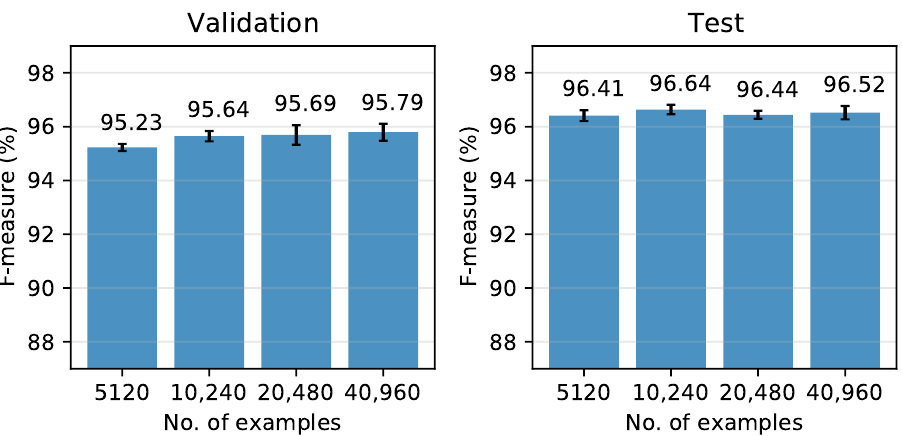
Figure 9. The overall F-measure for different training set sizes. These results were calculated on the validation set and test set. The bar chart shows the mean and standard deviation for five iterations of data synthesis and training using different random